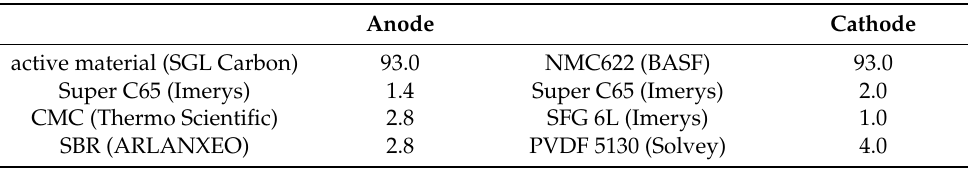
Table 1. Composition of the electrode coatings in wt%.